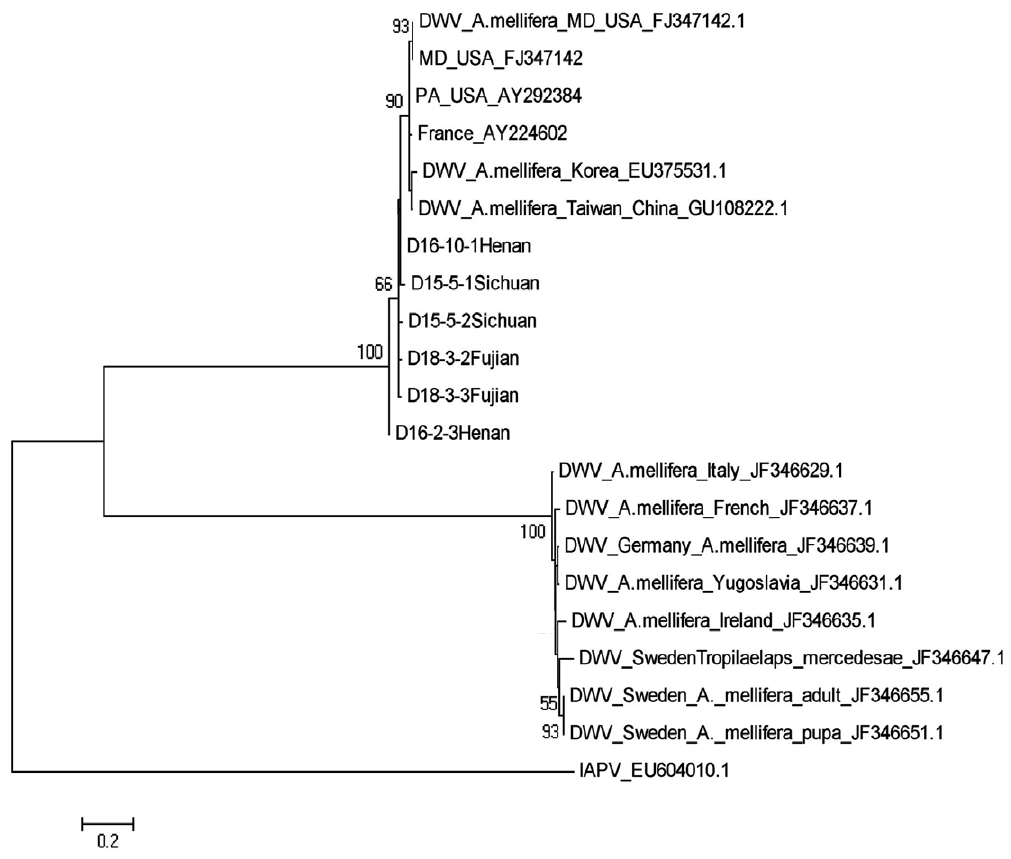
Figure 5. A phylogenetic tree showing the relationship of DWV isolates. The partial sequences of RNA dependent RNA polymerase (RdRp) of DWV from A. cerana collected from different geographic locations of China and from Apis mellifera retrieved from GenBank were aligned using ClustalW. The sequence of IAPV was used as an outgroup to root the tree. Numbers at each node represent bootstrap values as percentages of 500 and only bootstrap values greater than 50% are shown. doi:10.1371/journal.pone.0047955.g005 mites. Low levels of Varroa mite infestation could therefore explain the lower prevalence of DWV. The original host of the Varroa mite was the A. cerana from which spread to the poorly defended A.